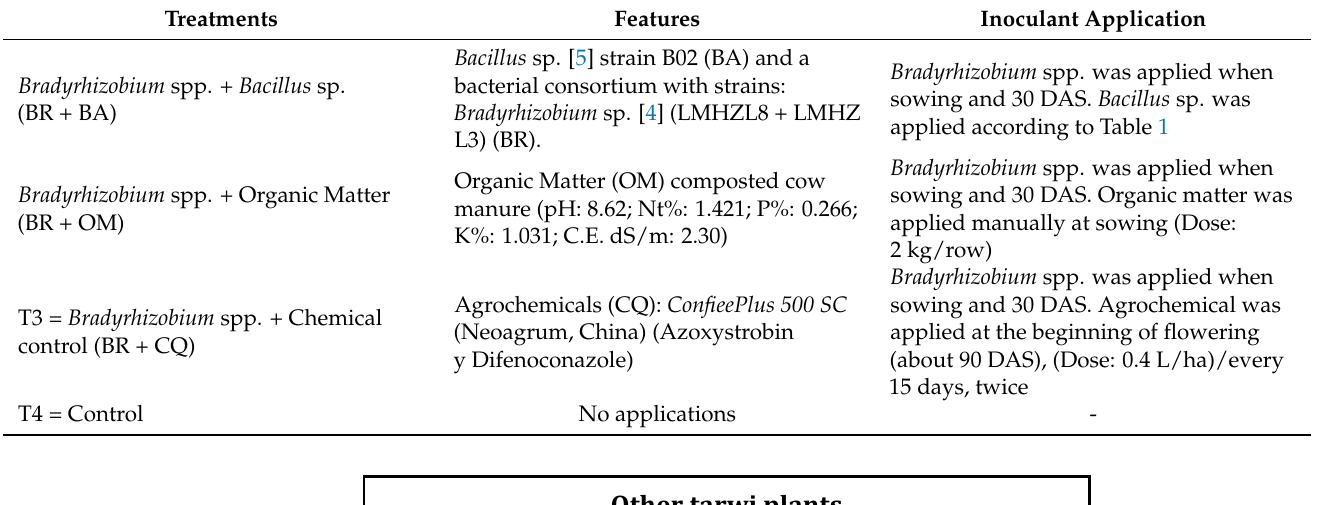
Table 2. Treatments used in the experimental trial.